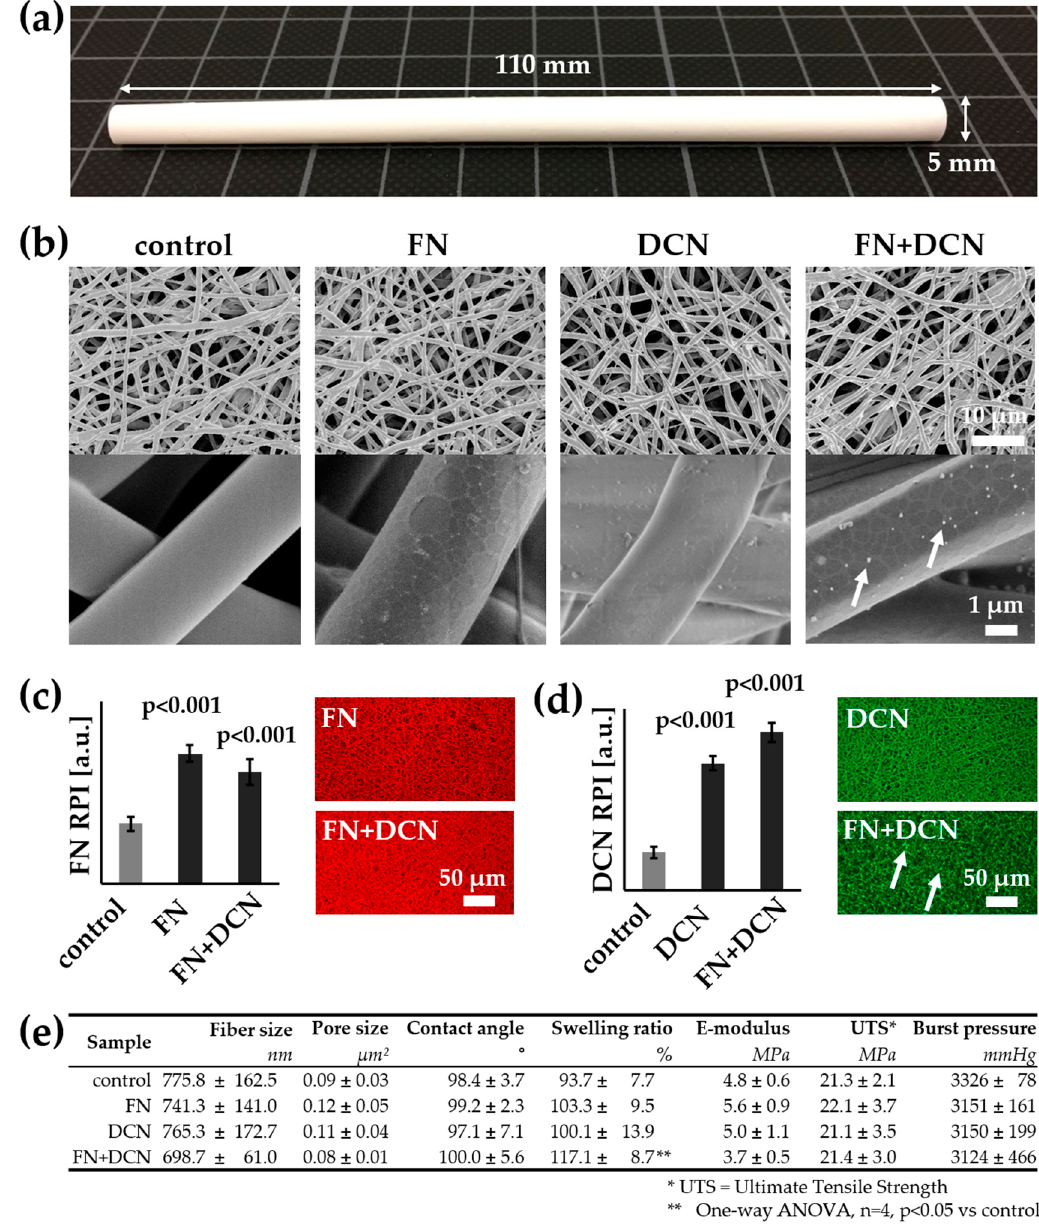
Figure 3. Morphological and mechanical characterization of the tubular biofunctionalized sca ff olds: ( a ) Electrospun tubular sca ff olds were fabricated with a length of 110 mm, an inner diameter of 5 mm, and a thickness of 0.40 ± 0.06 mm. ( b ) SEM images of control and biofunctionalized sca ff olds: Sca ff olds coated with FN show a network-like structure on the fibers. Aggregates deposited on the FN + DCN-coated samples are indicated by white arrows. ( c , d ) The coating of FN, DCN, or FN + DCN in combination was confirmed with IF staining: FN (red) and DCN (green). The white arrows indicate aggregates deposited on the FN + DCN-coated samples. Two-tailed t -test vs. control, n = 3, RPI = relative pixel intensity. ( e ) Fiber and pore size analysis shows no significant di ff erence between the biofunctionalized sca ff olds and the controls. Mechanical properties are not influenced by the protein coating. One-way ANOVA, n = 4, p < 0.05 vs.